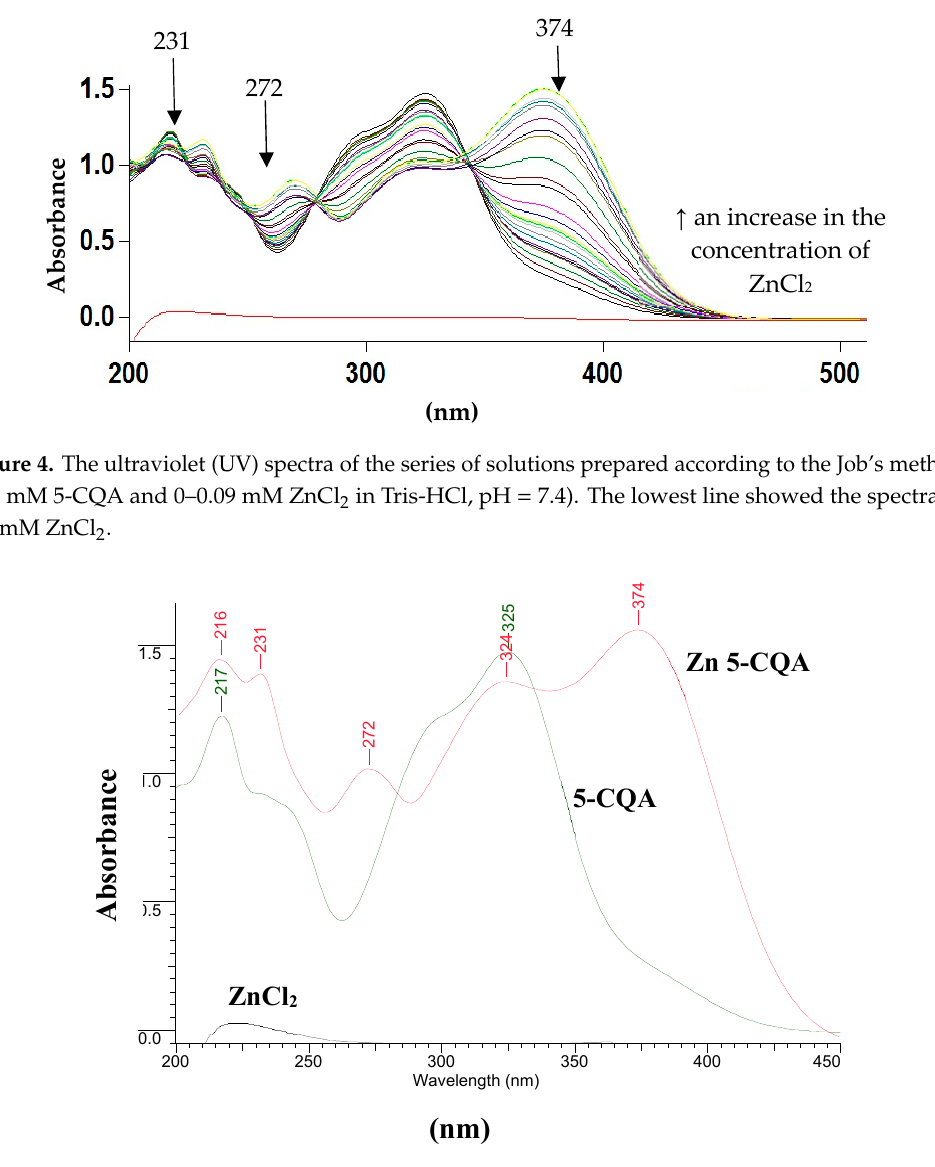
Figure 5. The UV spectra of 0.1 mM ZnCl 2 , 0.1 mM chlorogenic acid (5-CQA), 0.05 mM ZnCl 2 plus 0.1 mM 5-CQA (molar ratio Zn:5-CQA 1:2) in Tris-HCl at pH = 7.4 registered in the range 200–450 nm.